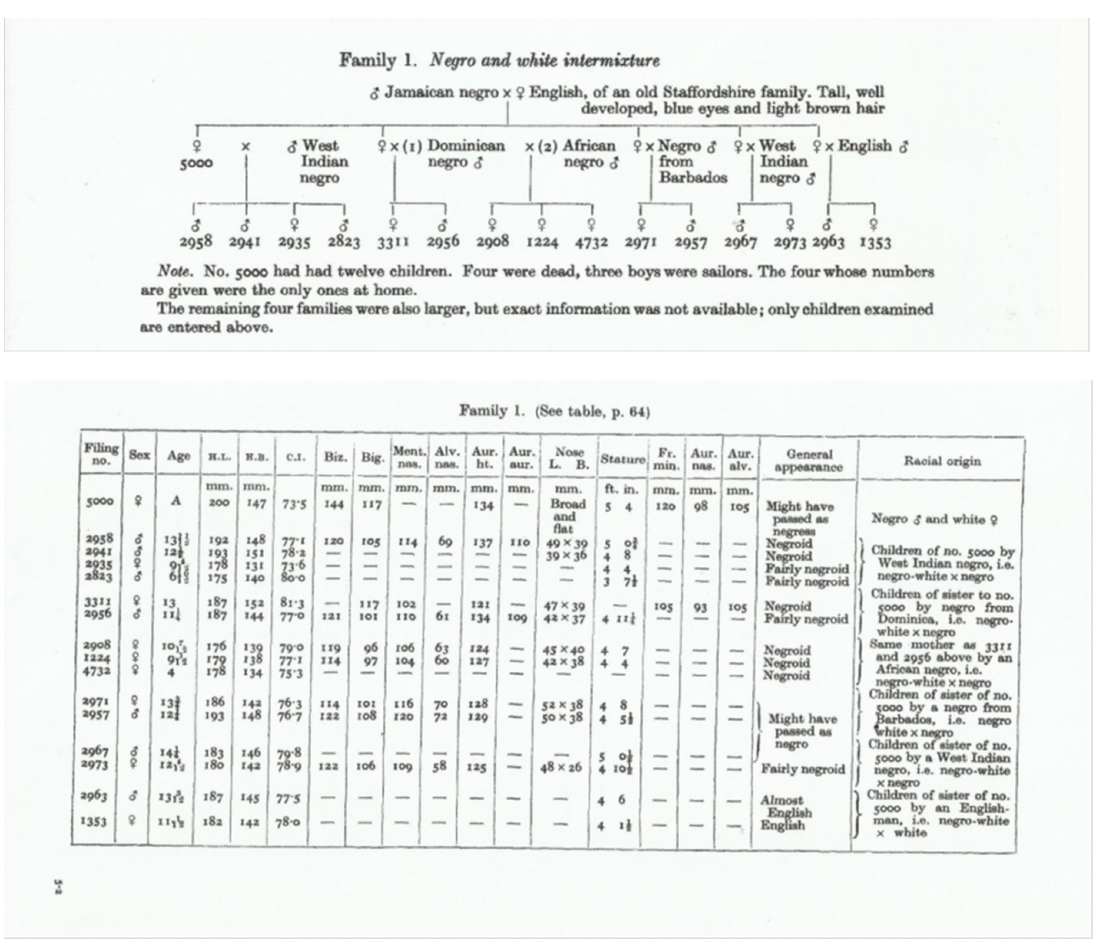
Figure 3. Members of a large family of ‘Negro and white intermixture’ and measurements taken. Source: The family was observed by Rachel Fleming, see (Fleming 1939).